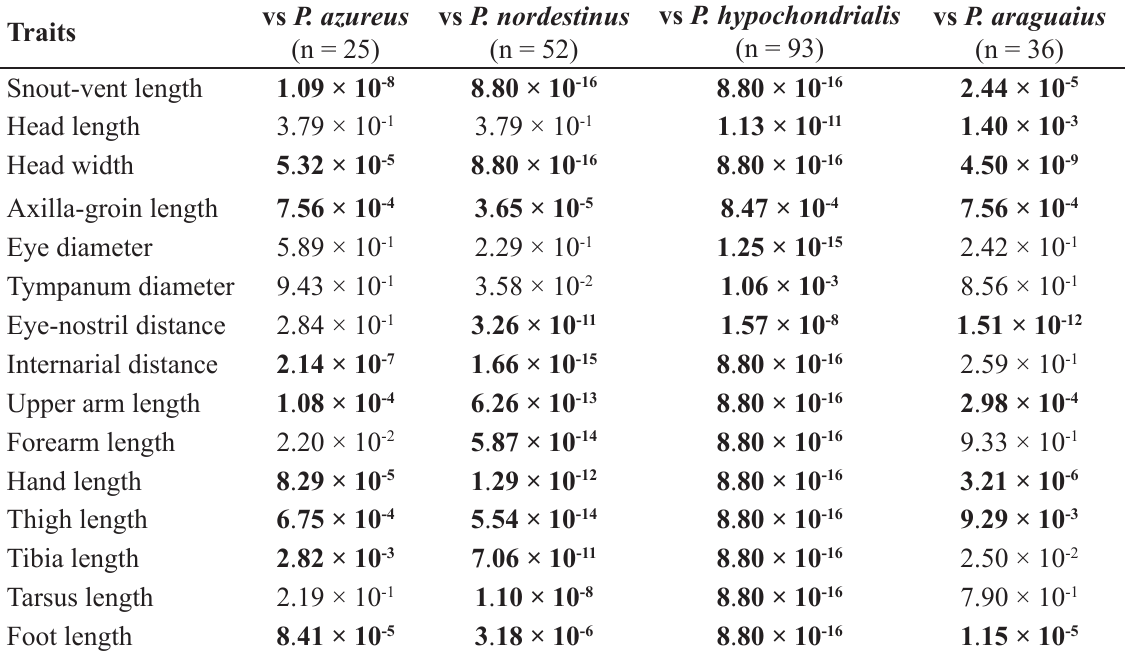
Table 3. P- values obtained using Exact Wilcoxon-Mann-Whitney Test based on morphometric comparisons between Pithecopus gonzagai sp. nov. (n = 159) and its closer relatives; P < 0.01 in bold . n = number of males measured. Further details on all males examined are in the Material and methods section and in the